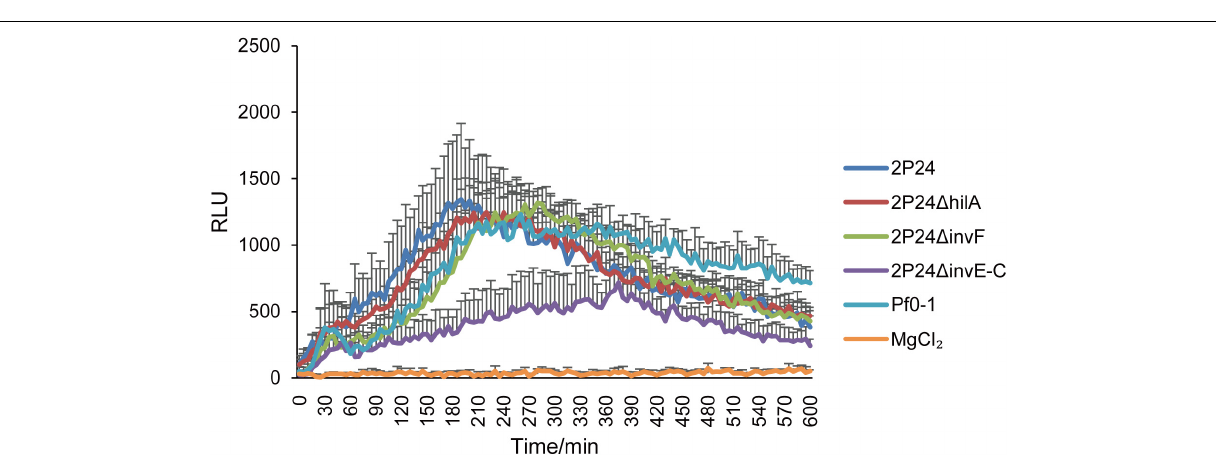
FIGURE 8 | Biofilm formation of strain 2P24 and SPI-1 related mutants incubated in KB medium for 12, 24, and 48 h in 2 mL centrifuge tubes. Data are means of three replicates. Error bars represent SD. Means shown with the same letters are not different statistically at the 5% confidence level on the basis of Duncan’s multiple range test.